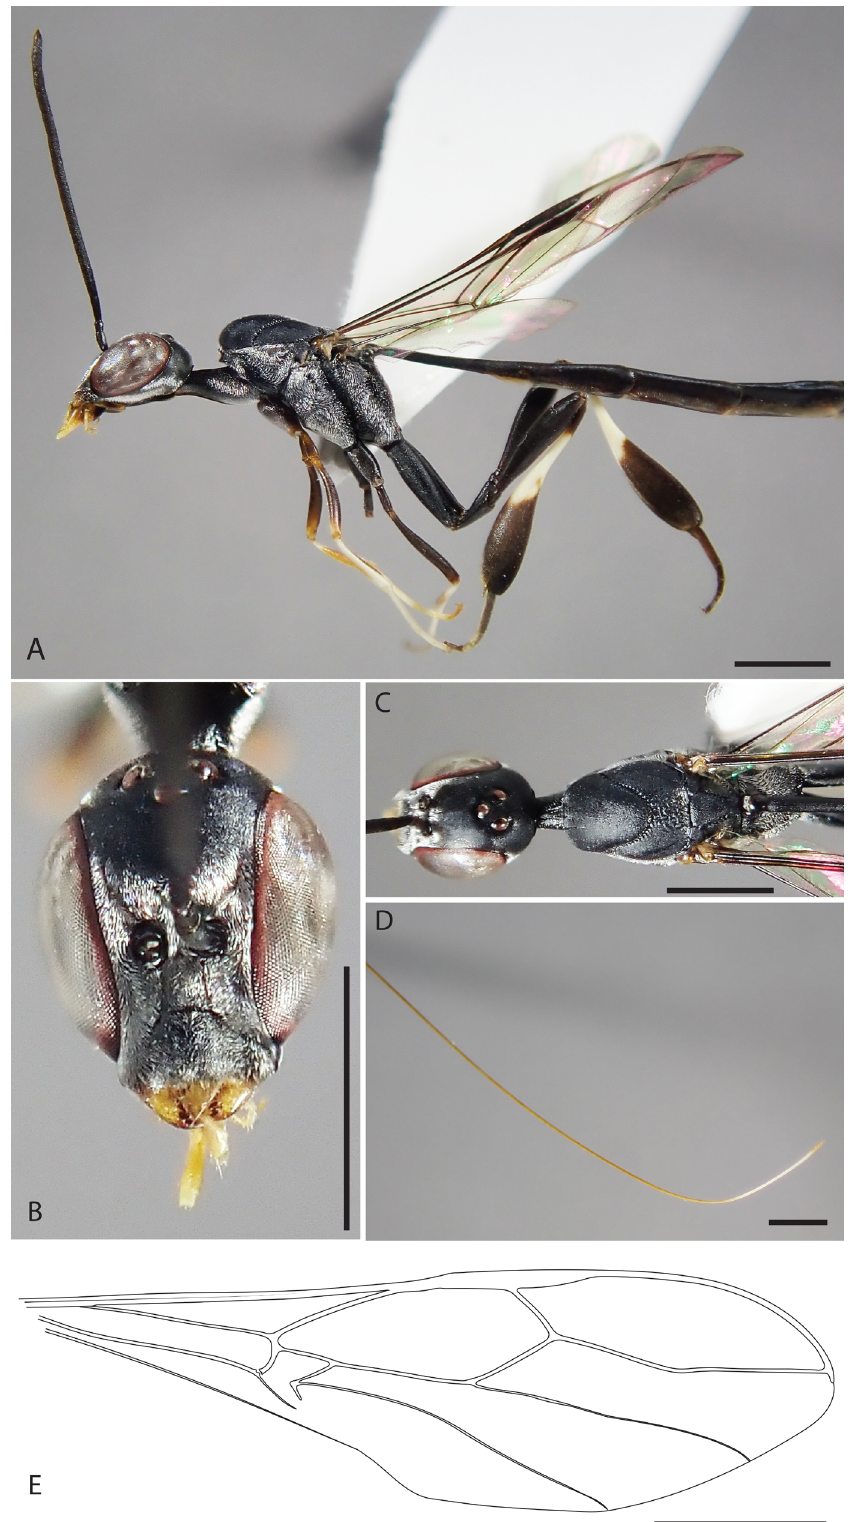
Fig. 8. Gasteruption jenningsi sp. nov., holotype, ♀ (MNHN). A . Mesosoma in lateral view. B . Head in full-face view. C . Mesosoma in dorsal view. D . Apex of the ovipositor. E . Line drawing of the fore wing venation. Scale bars = 1.0